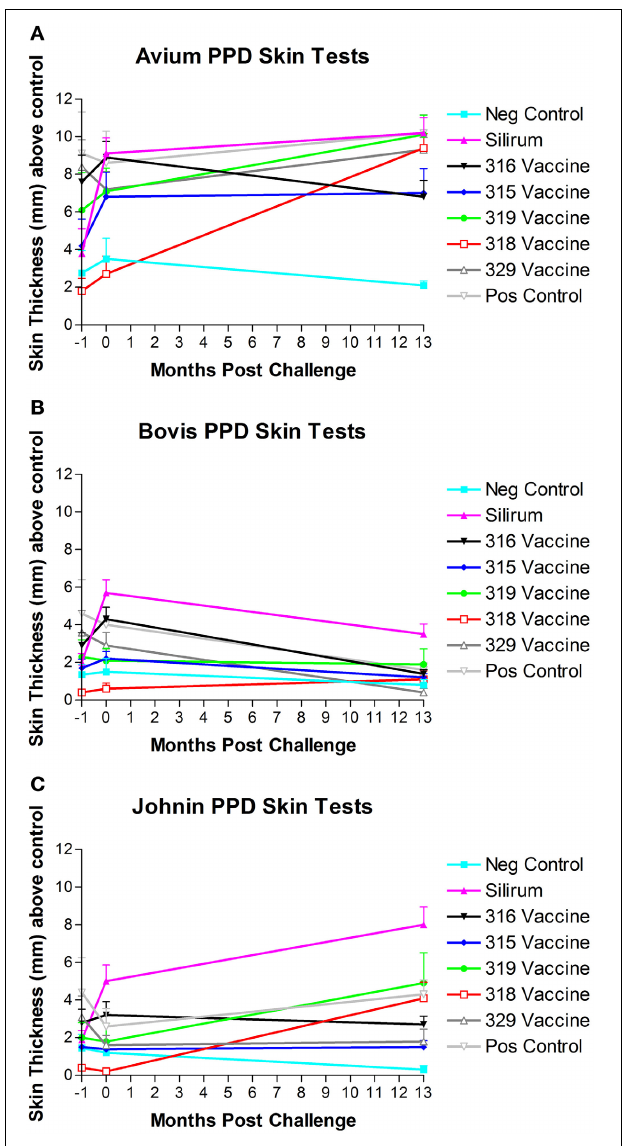
FIGURE 7 | (A–C) PPD skin test results over time. Note the strong skin responses to M. avium (A) and Johnin (C) PPD in multiple groups, and the generally lower responses to M. bovis (B) PPD with the exception of the Silirum® and 316 vaccines. (Error bars represent standard error of the mean, − 1 is baseline bleeding, 0 is challenge date and 1–13 represents months